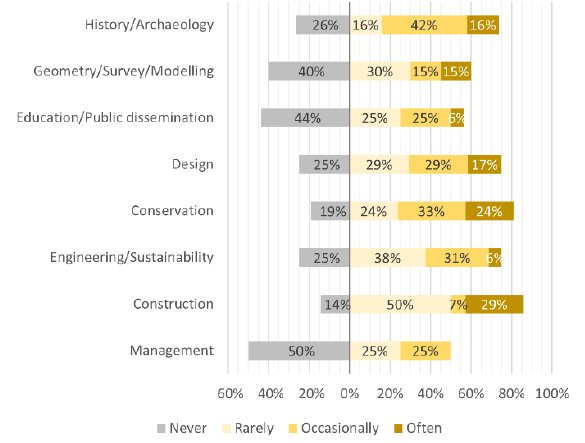
Figure 20: Access needed for pathologic data by the different groups.